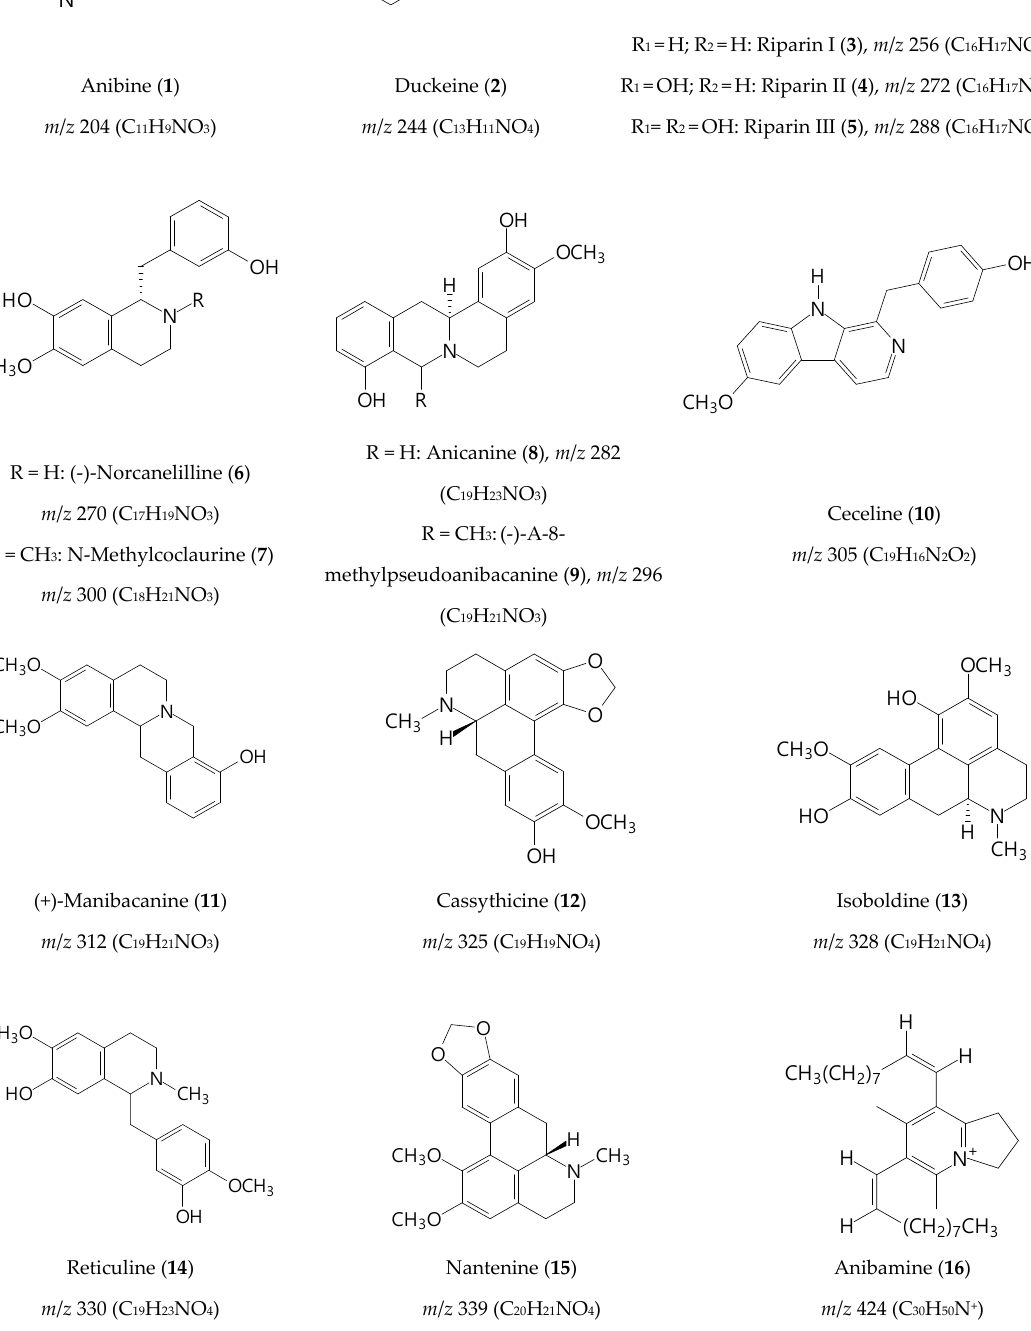
Figure 5. Chemical structures, m / z and chemical formulas of alkaloids putatively identified by PSMS in seed and peel of avocado .